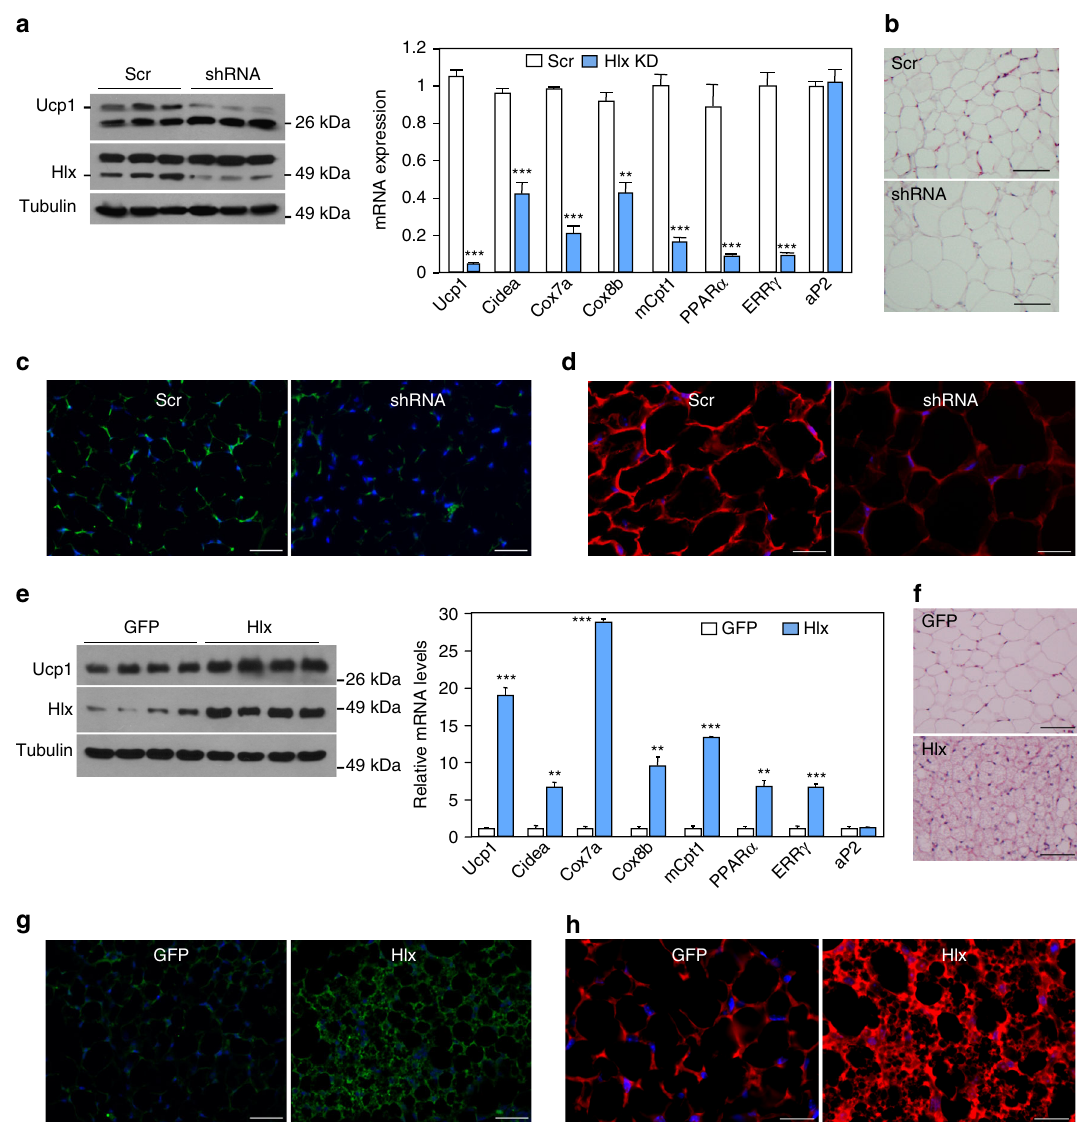
Fig. 3 Fat-speci fi c Hlx knockdown and overexpression through viral injection remodel WAT in vivo. a iWAT of wild-type mice was injected with Hlx knockdown lentiviruses. Protein and mRNA expression were analyzed ( n = 3 mice per group). b H&E staining of iWAT injected with Hlx knockdown lentiviruses. Shown are representative images of three mice per group. Scale bar , 200 µ m. c , d Ucp1 staining ( c ) and MitoTracker staining ( d ) of iWAT injected with Hlx knockdown lentiviruses. Shown are representative images of three mice per group. Blue , DAPI. Scale bar , 200 µ m. e iWAT of wild-type mice was injected with Hlx overexpression adenoviruses. Protein and mRNA expression were analyzed ( n = 4 mice per group). f H&E staining of iWAT injected with Hlx overexpression adenoviruses. Shown are representative images of three mice per group. Scale bar , 200 µ m. g , h Ucp1 staining ( g ) and MitoTracker staining ( h ) of iWAT injected with Hlx overexpression adenoviruses. Shown are representative images of three mice per group. Blue , DAPI. Scale bar , 200 µ m. All injections were repeated with independent cohorts of mice. Tom20 staining was also performed in ( d ) and ( h ) and similar results were obtained. All error bars represent s.e.m. Two-tailed unpaired Student ’ s t-test was performed. ** p < 0.01; *** p <